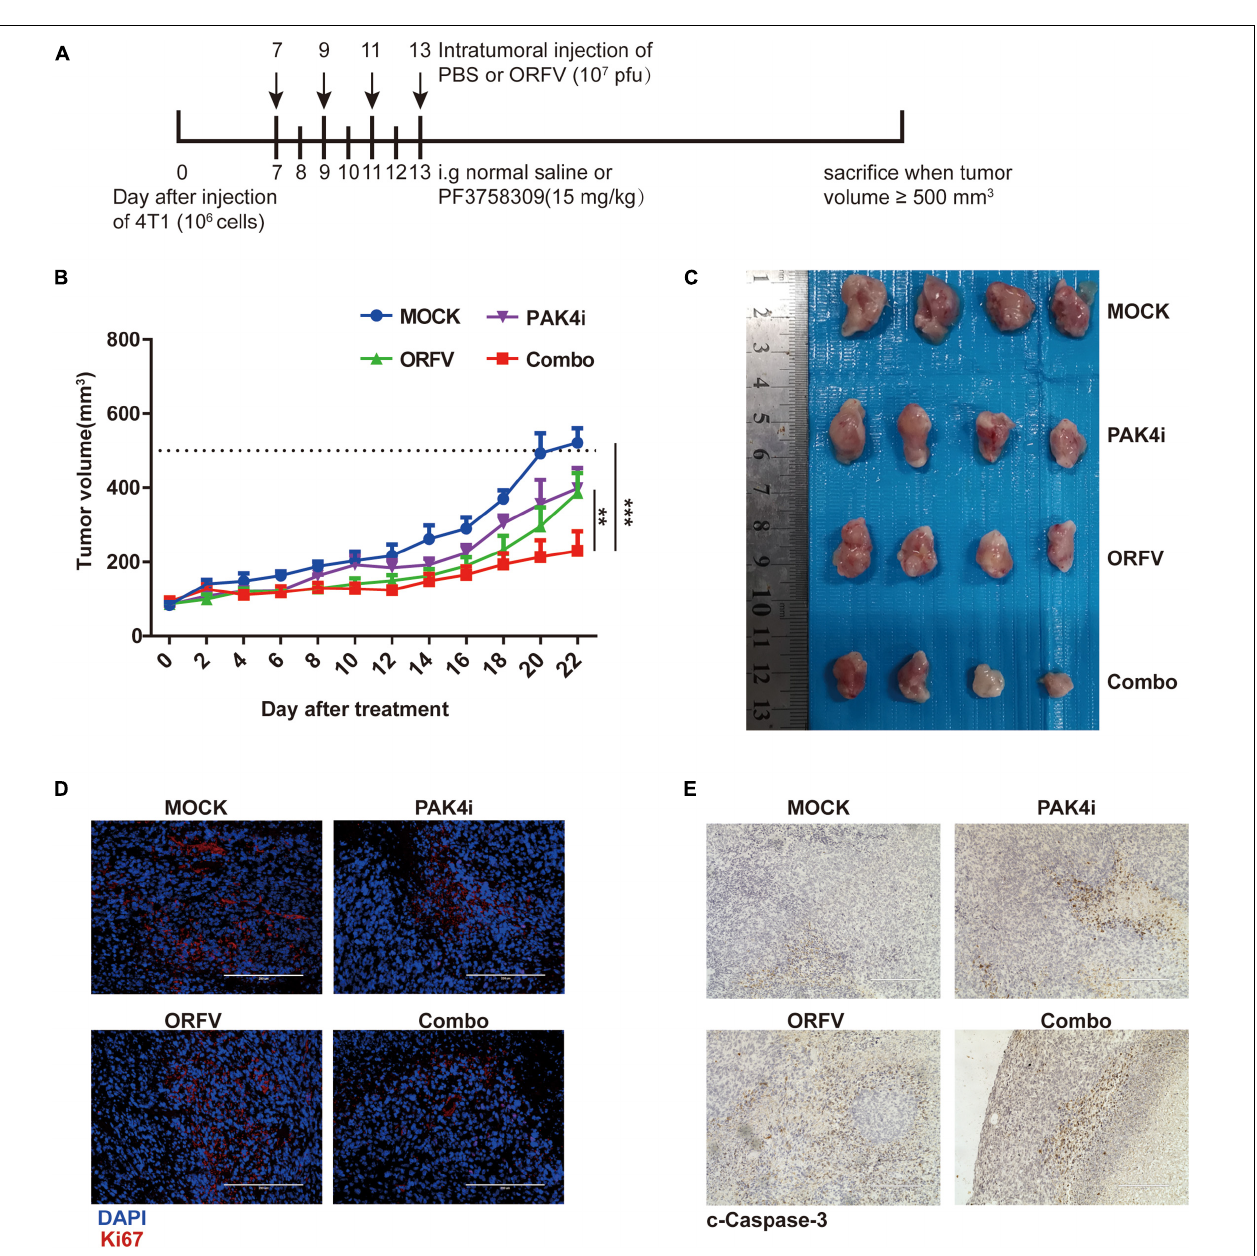
FIGURE 7 | ORFV inhibited tumor growth on 4T1 allograft tumor in BLAB/c mice. (A) Different treatments on tumor-bearing mice was performed in accordance with the illustrated time schedule. (B) The tumor volume was measured every 2 days, and the tumor growth curve was drawn. (C) Images of 4T1 tumor of BLAB/c mice received various treatments. (D) Representative immunofluorescence results of Ki67 expression in tumor tissues of BALB/c mice received various treatments. (E) Representative IHC results of c-Caspase-3 expression in tumor tissues of BALB/c mice received various treatments. The results are expressed as the means ± SEM of three independent experiments. ** p < 0.01; *** p <